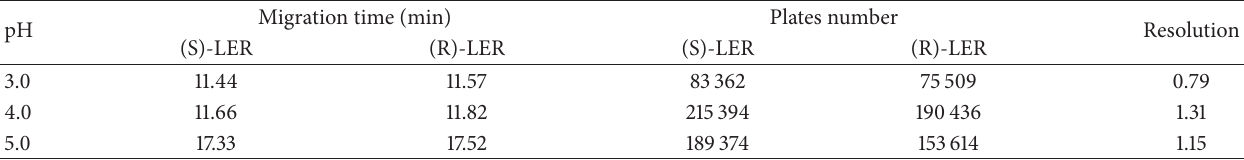
Figure 3: Effect of (a) TM- 𝛽 -CD concentration (mmol/L); (b) buffer concentration (mmol/L); (c) temperature ( ∘ C) and (d) voltage (kV) on the migration time (min) of LER enantiomers. Experimental conditions: fused-silica uncoated capillary 50 𝜇 m id, 60.2 cm in total length and 50.0 cm in effective length, sodium acetate buffer pH 4.0, and 15 ∘ C, 25 kV, 237 nm, and injection: 10 seconds (at a pressure of 0.5 psi). Other conditions were changed according to each experiment. Table 1: Results of the pH test for LER enantiomers